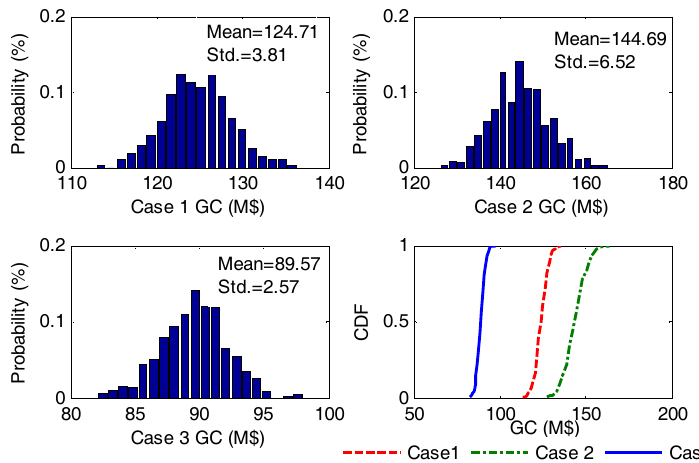
Table 1. Detailed results for cases 1–3.